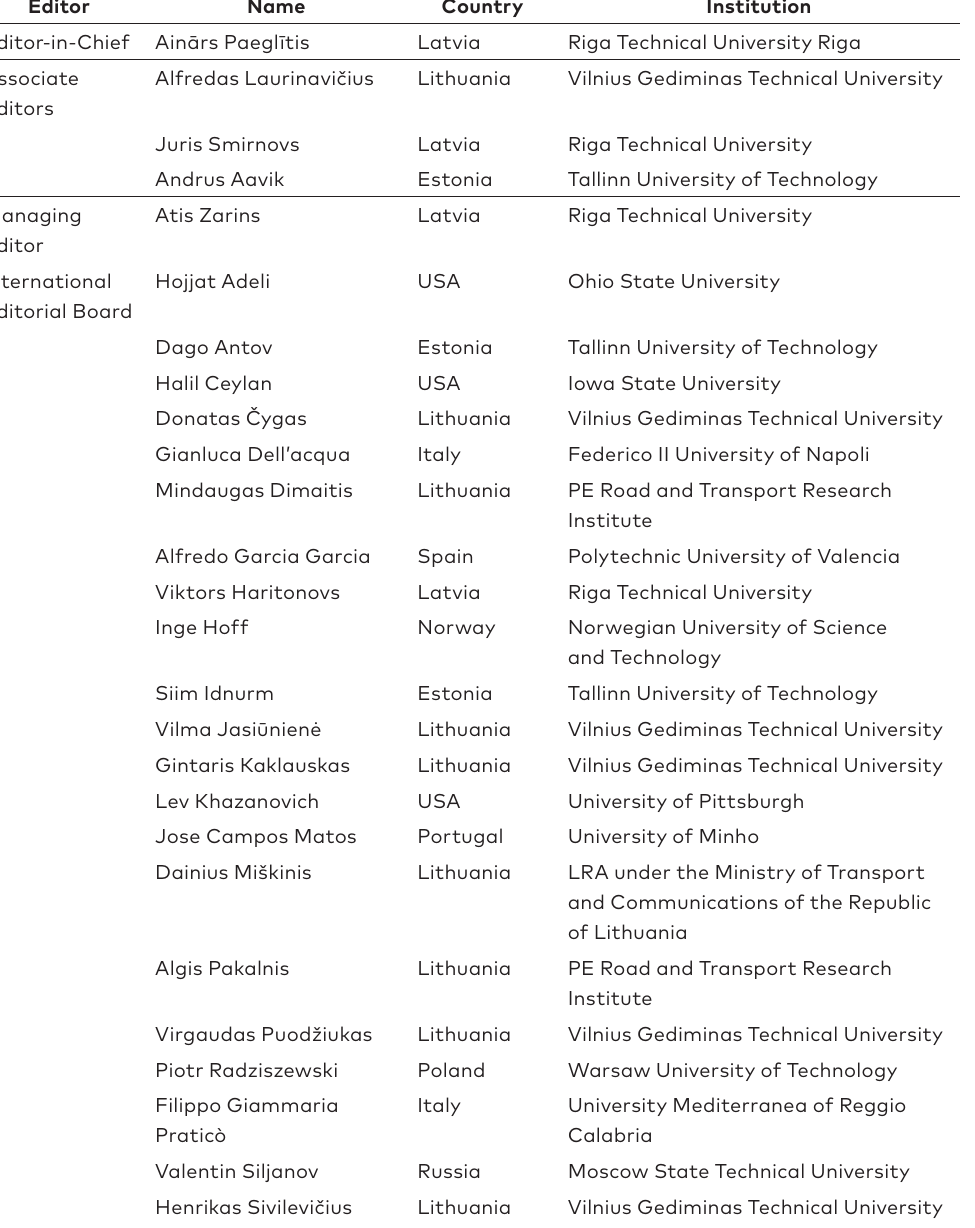
Table 2. The list of Editorial Board of The Baltic Journal of